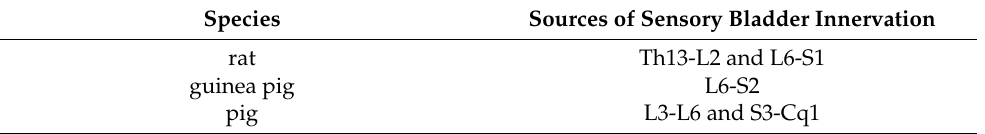
Table 1. Comparison of neuromere levels at which dorsal root ganglia (DRG) neurons involved in the urinary bladder afferent innervation may be found in various animal species studied so far by means of retrograde